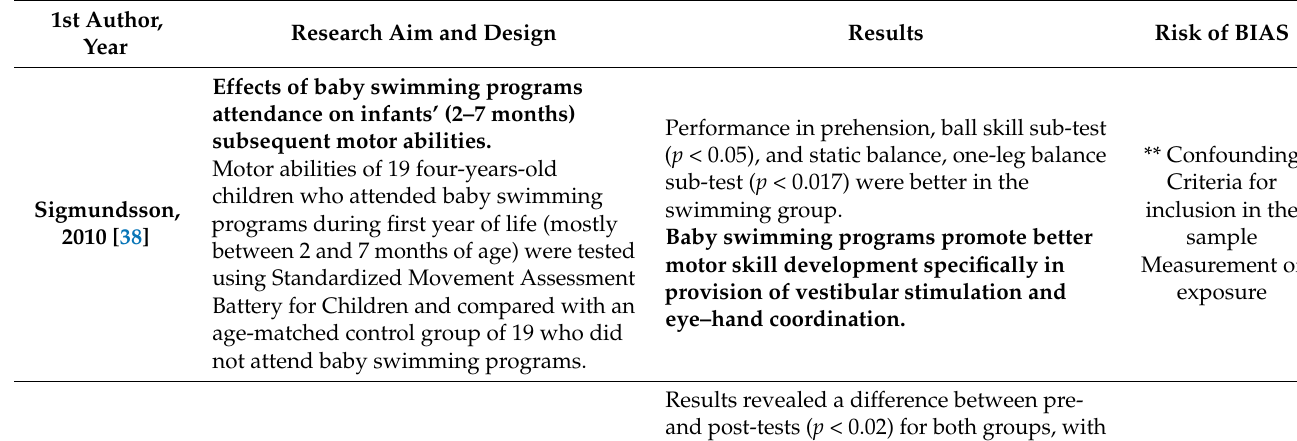
Table 3. Effects of exposure to baby swimming programs on infants’